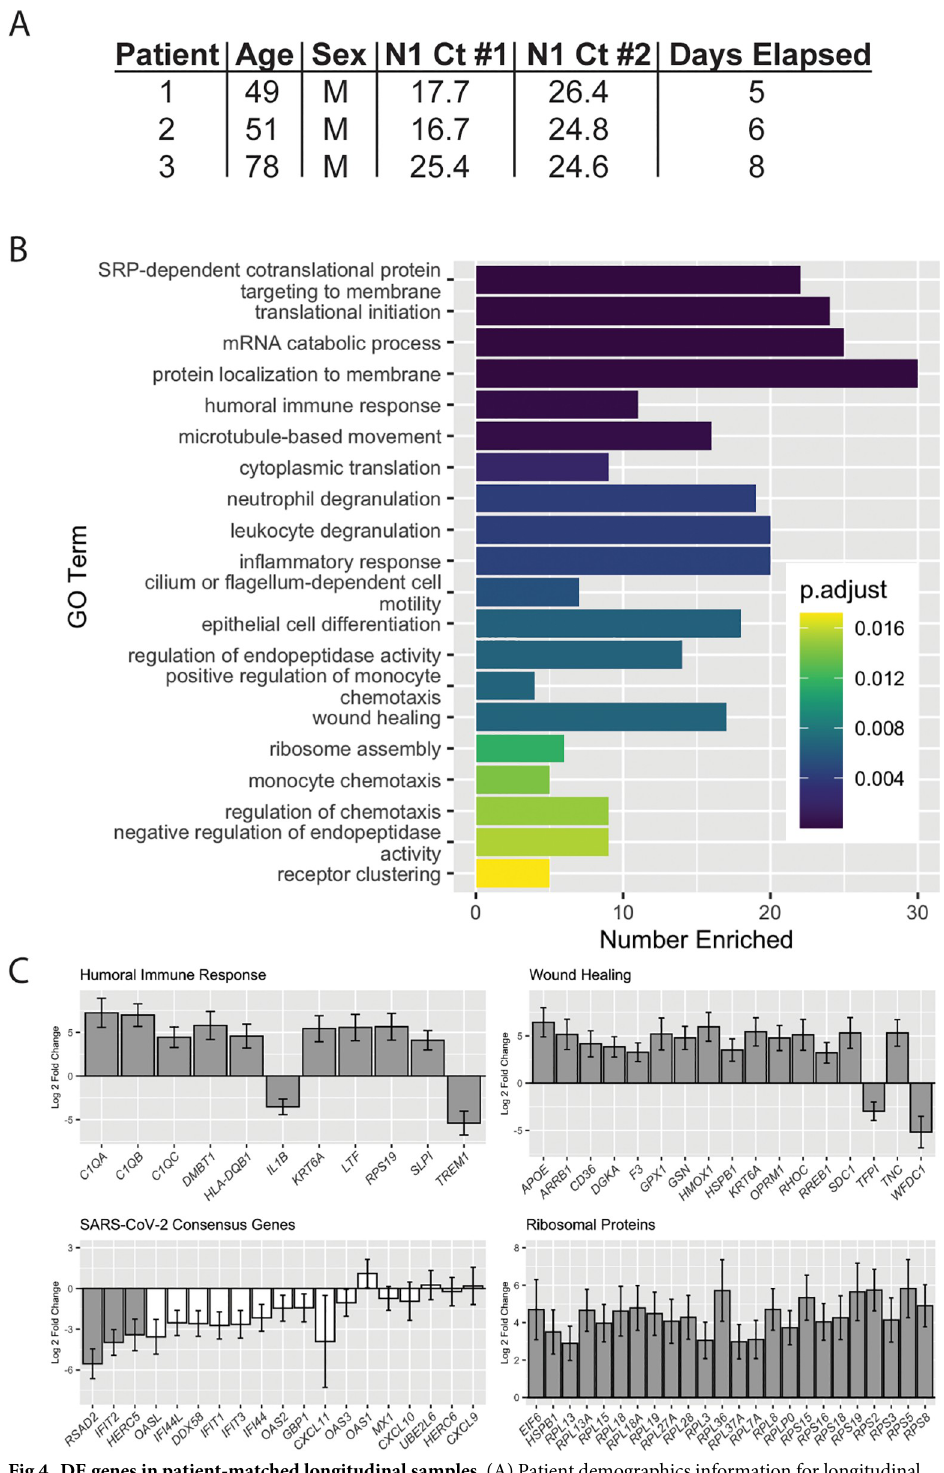
Fig 4. DE genes in patient-matched longitudinal samples. (A) Patient demographics information for longitudinal samples. (B) Top 20 Biological Process GO terms for which longitudinal DE genes are overrepresented. “Number Enriched” is the number of DE genes that belong to each GO term. (C) Log2 fold changes for DE genes in Humoral Immune Response and Wound Healing GO terms, consensus antiviral SARS-CoV-2 genes, and ribosomal proteins. Grey bars: p adj < 0.1, white bars: p adj > 0.1. Raw data available in the GEO Repository, accession GSE154769. Ct,